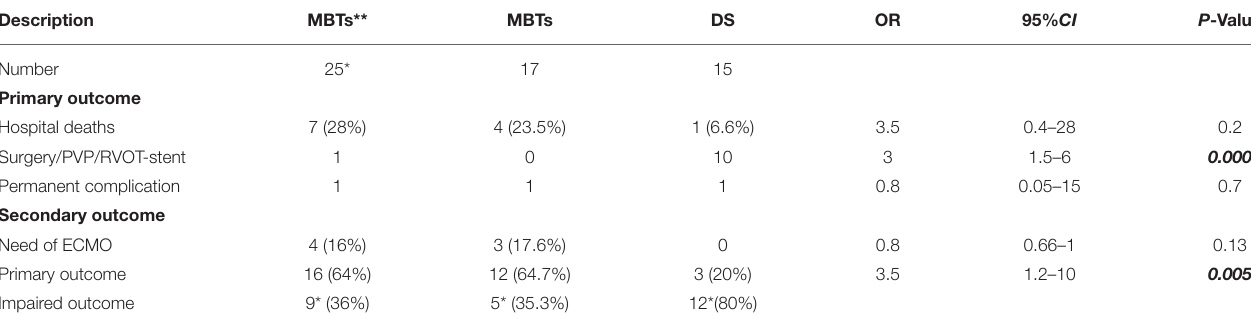
TABLE 2 | DS vs MBTs in patients with ductal curvature index > 0.45.